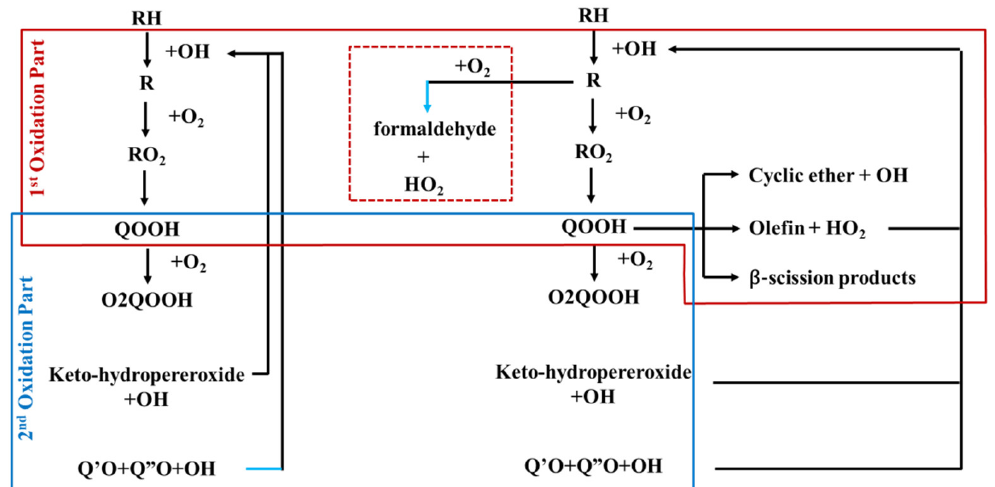
Figure 3. Reaction pathways of pure n-heptane ( left ) and n-heptane/methane-blended fuels ( right ).